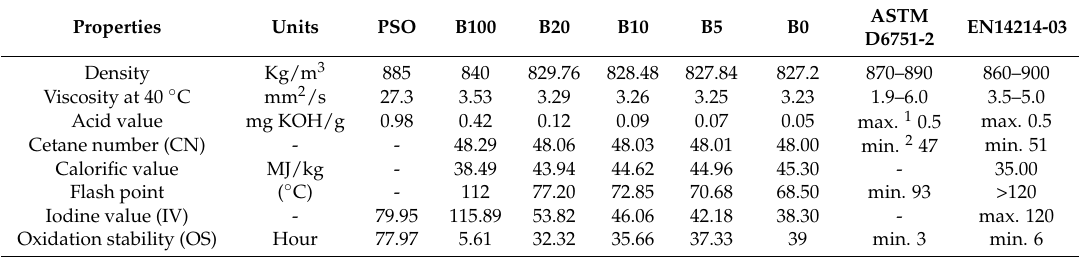
Table 4. Comparison of PSO biodiesel and blends with diesel.